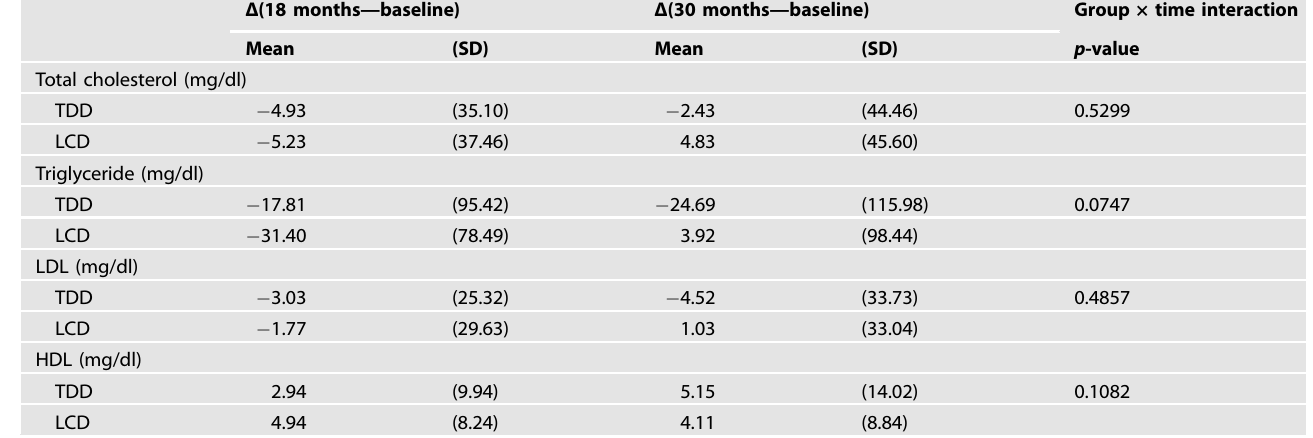
Table 4. Change of lipid pro fi le at the end of 18-month intervention and one year after adjusted with statin and fi